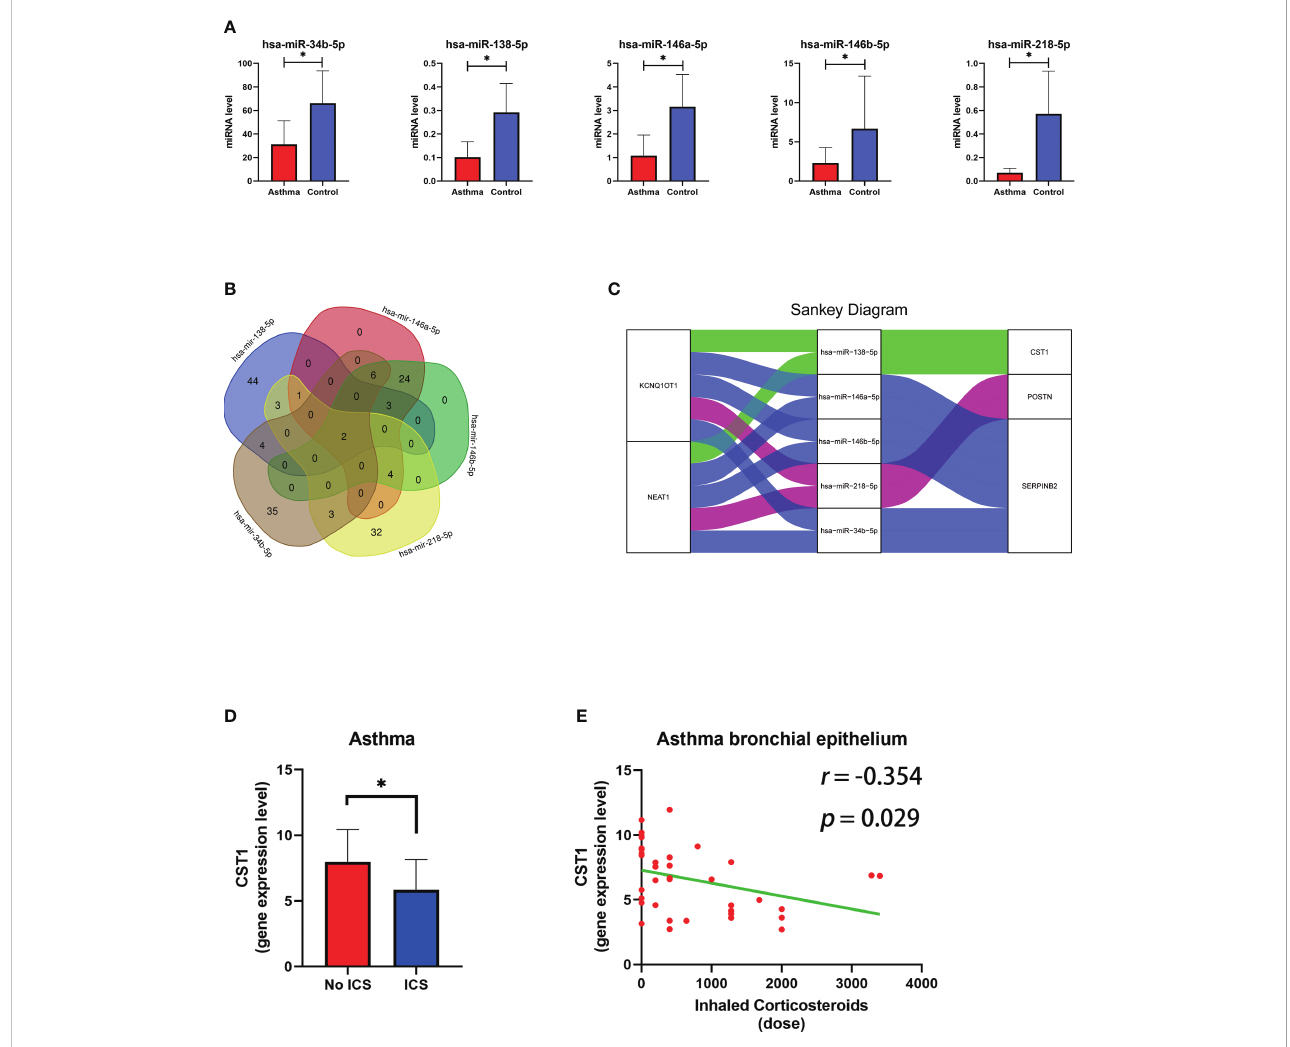
FIGURE 9 The construction of the lncRNA – miRNA – mRNA ceRNA network of key genes and relationship between ICS and CST1 expression levels. (A) Histogram of the expression levels of fi ve predicted miRNAs in the bronchial epithelium of asthma patients. (B) Venn diagram of lncRNA predicted by the miRNet database involved in the regulation of all miRNAs. (C) The sankey diagram of the ceRNA network. (D) Histogram of CST1 expression levels in the bronchial epithelium of asthma patients with and without ICS. (E) Correlation analysis and scatter plot of CST1 expression level in bronchial epithelium of